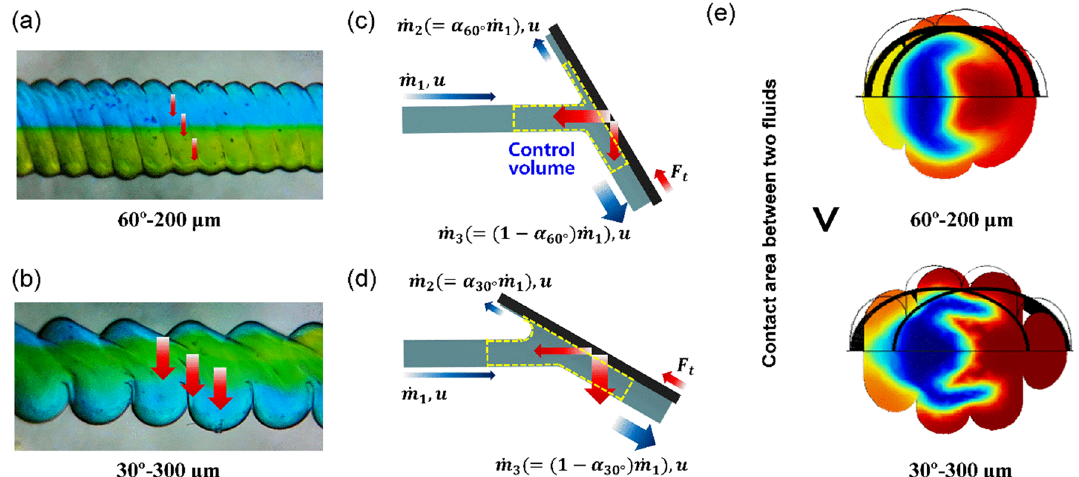
Figure 8. Fluidic analysis in the mixing channel from a fluid dynamic point of view: ( a ) flow in the 60°– 200 μm, ( b ) schematic of control volume analysis of force balance with the 60°-oblique pattern, ( c ) flow in the 30°–300 μm, and ( d ) schematic of control volume analysis of force balance with the 30°-oblique pattern. ( e ) Cross-sectional view of two fluids, and comparison of interfacial shape during “split” and “recombine” actions with respect to the angle of